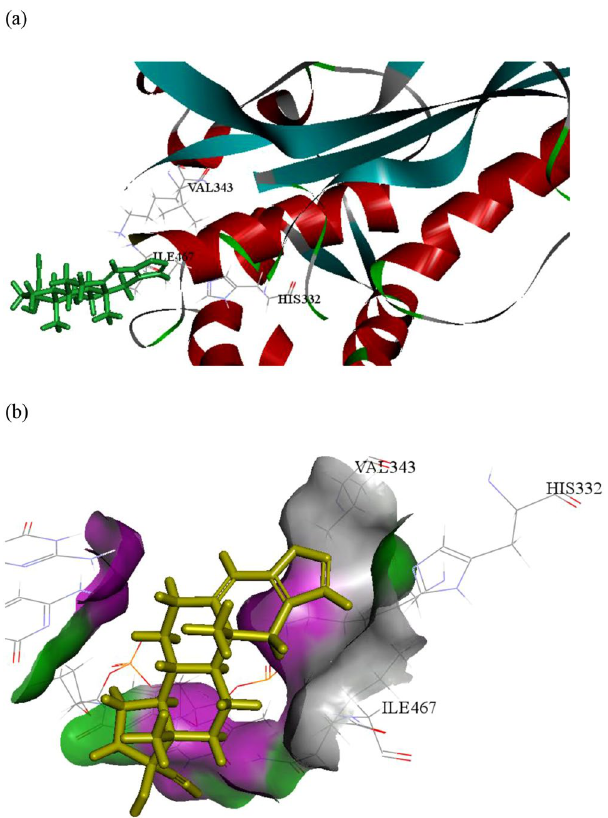
Figure 7. Molecular docking analysis of danazol with STAT3. ( a ) Superimposition of docked position of compound in the STAT3-binding pocket of 3D structure (PDB entry 1BG1). ( b ) 3D model representation of the adduct danazol with